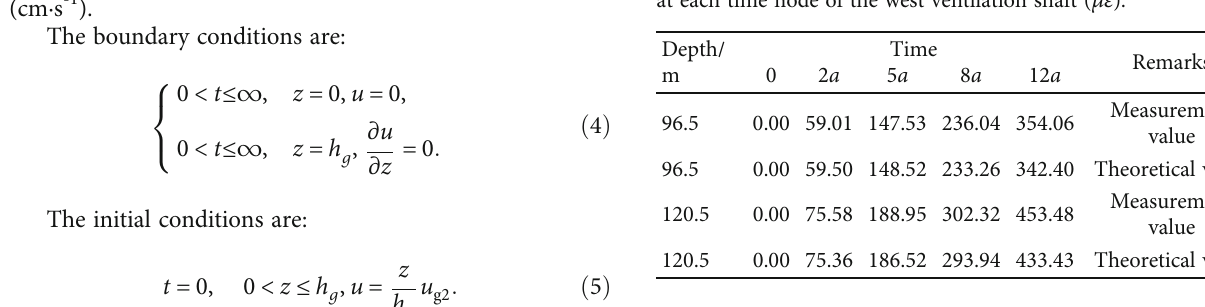
Figure 10: Relationship between the additional force and time and depth of the shaft. Table 2: The theoretical and measurement values of concrete strain at each time node of the west ventilation shaft ( με